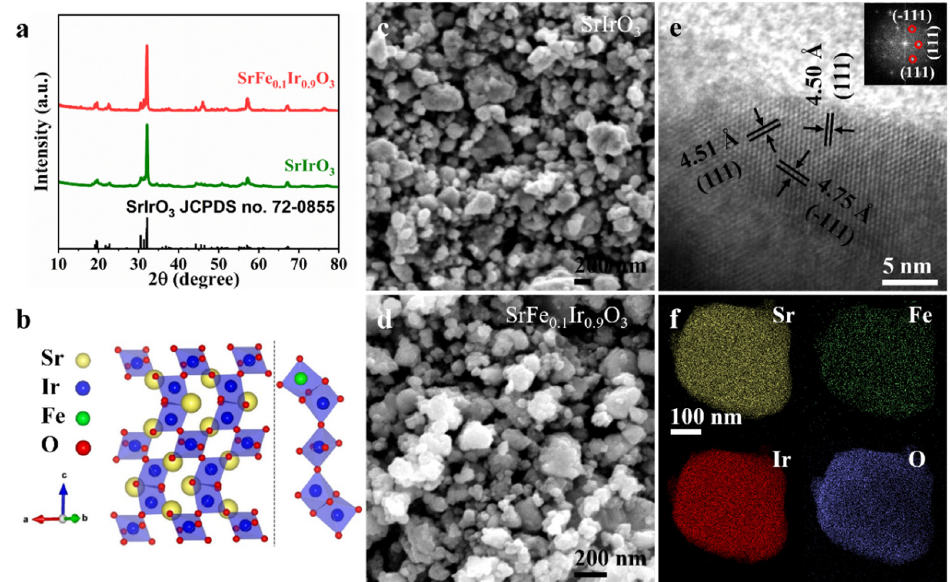
Figure 1. ( a ) XRD patterns of SrFe 0.1 Ir 0.9 O 3 and SrIrO 3 . ( b ) Crystal structure of SrIrO 3 and the proposed Fe-doped local connection pattern of IrO 6 octahedra in monoclinic SrFe 0.1 Ir 0.9 O 3 . ( c ) SrIrO 3 and ( d ) SrFe 0.1 Ir 0.9 O 3 . ( e ) HRTEM image captured from SrFe 0.1 Ir 0.9 O 3 . Inset: the corresponding fast Fourier transform image. ( f ) The elemental mapping images of a typical nanoparticle of SrFe 0.1 Ir 0.9 O 3 .